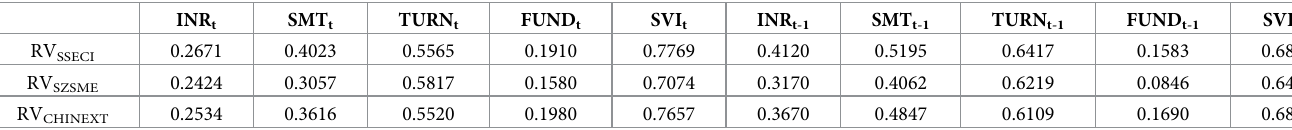
Table 2. The correlation coefficients between the realized volatility and the proxy variables. INR t